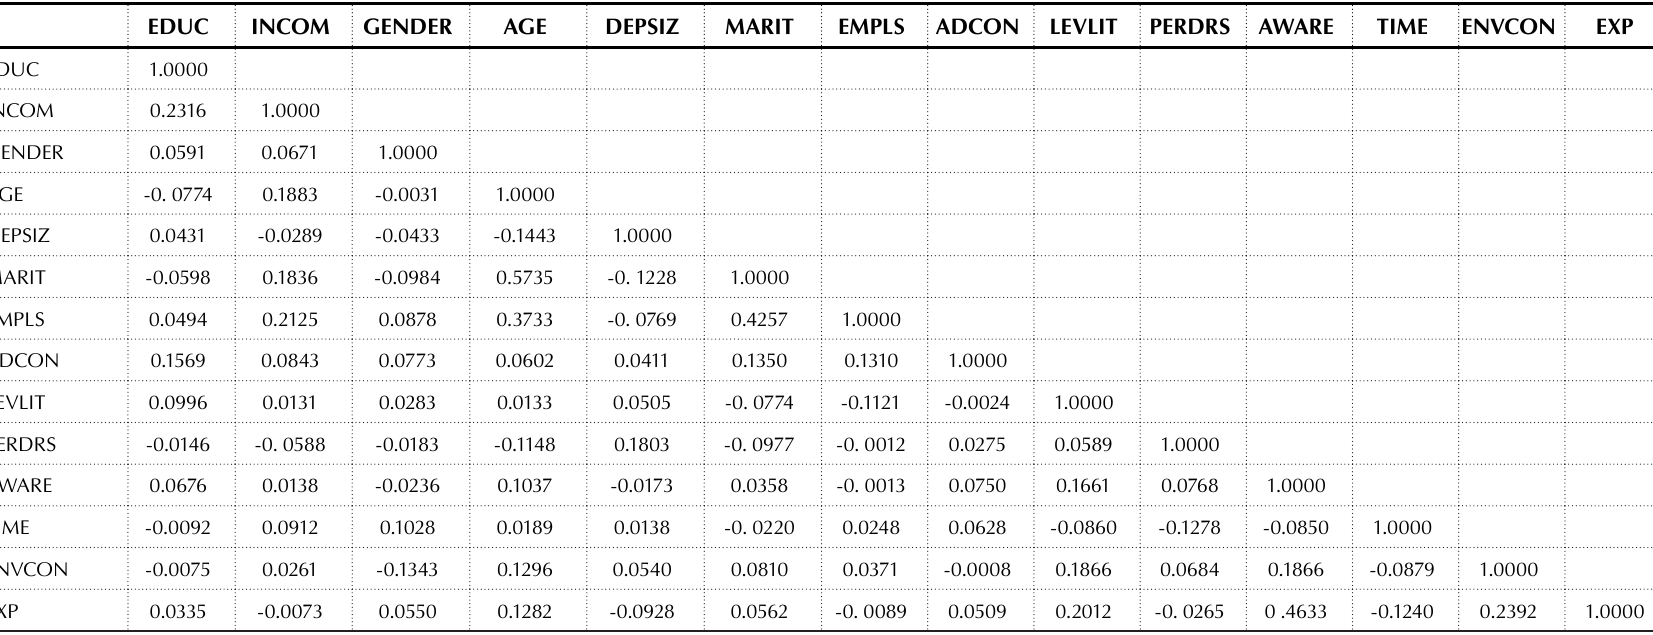
Table 1A. Correlation matrix for the explanatory